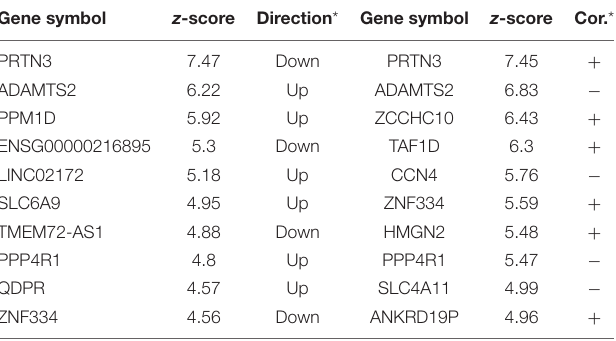
TABLE 2 | Top 10 genes for classifying the subjects into fast episodic memory decline and slow episodic memory decline and top 10 genes predictive of episodic memory in the full